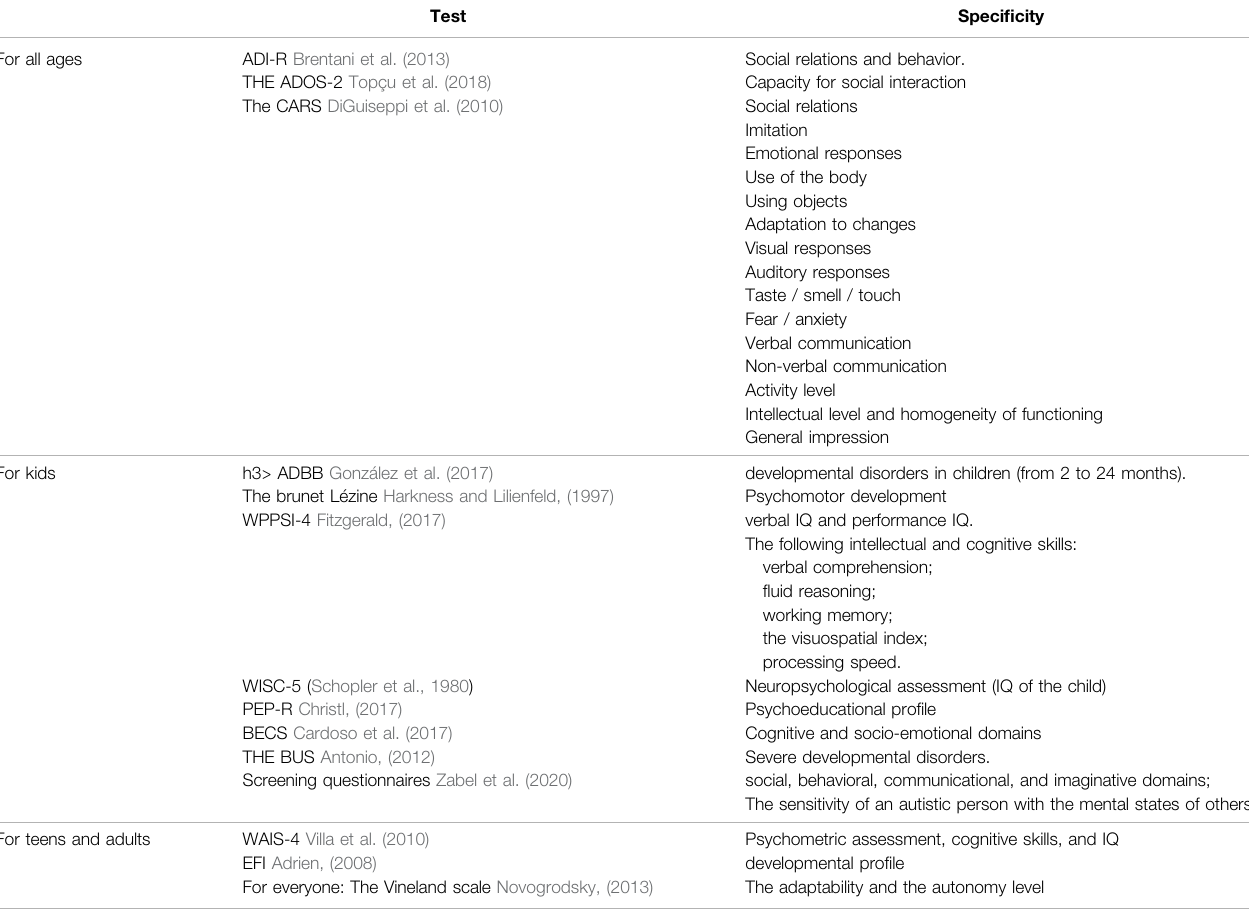
TABLE 1 | Psychometric tests for all age